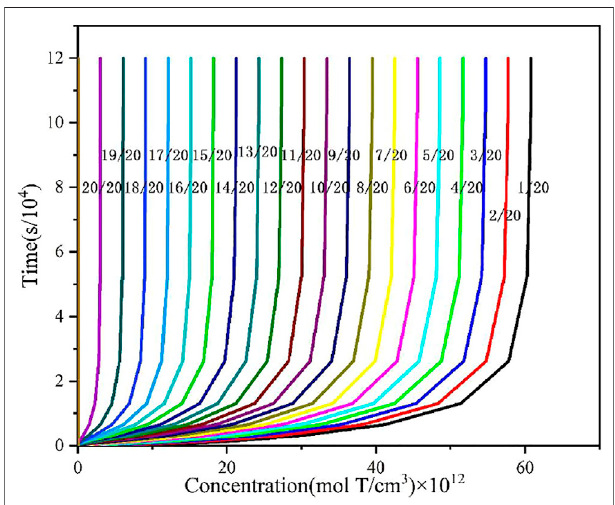
FIGURE 4 | Tritium distribution in the FeCrAl cladding at the end of the simulation.